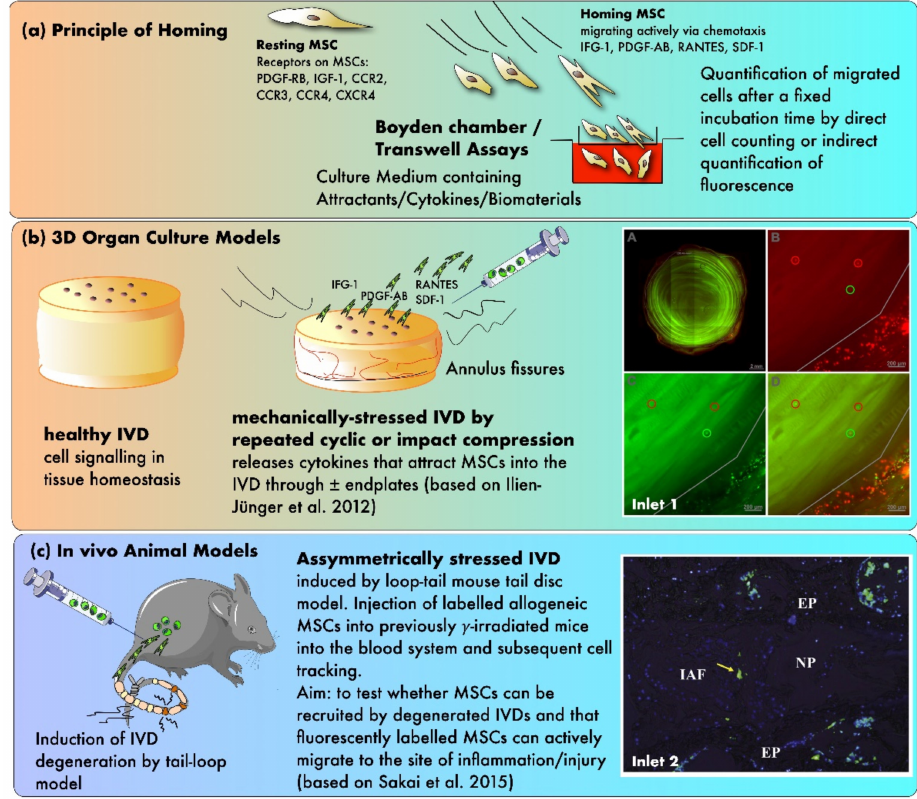
Figure 3. The principles of testing MSC homing in mechanically and/or nutritionally stressed IVDs. ( a ) Principle of homing using in vitro Boyden chamber assays ( b ) Testing of homing in 3D organ culture models ( c ) Evidence from in vivo animal models. Inlet 1: confocal laser scanning pictures (cLSM) of MSC homing experiment with differently labeled MSCs (green, red, and yellow) that were added at various time points during the experiment (A) a transverse section of a bovine IVD without endplates (B–D) close-up pictures at the outer AF (based on Illien-Jünger et al. [93]) Inlet 2: fluorescent image illustrating single stained MSCs in the outer periphery of the AF after 12 weeks post-injection, 10 × magnification (based on Sakai et al. [92]). Inlet 2 was reproduced with copyright approval from the